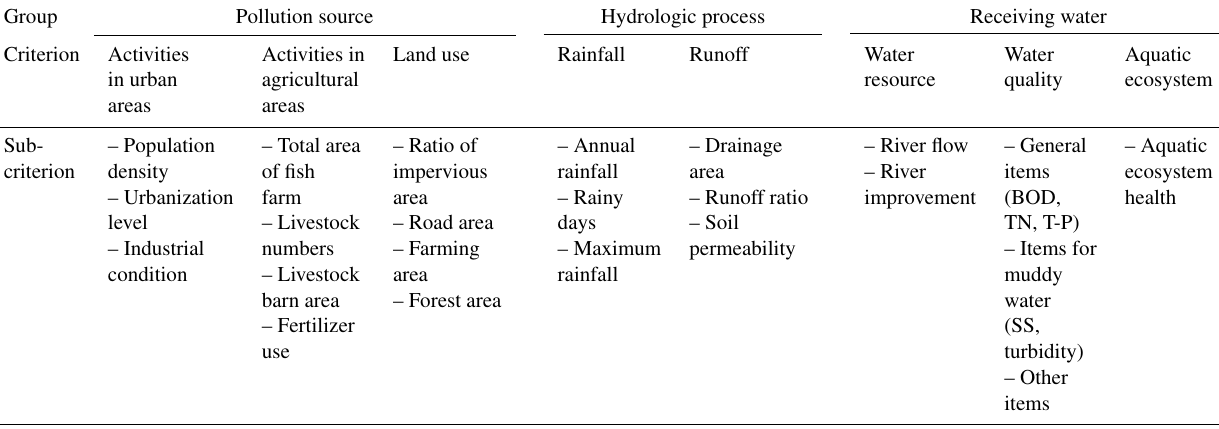
Table 1. A set of criteria and sub-criteria for the draft of evaluation framework.